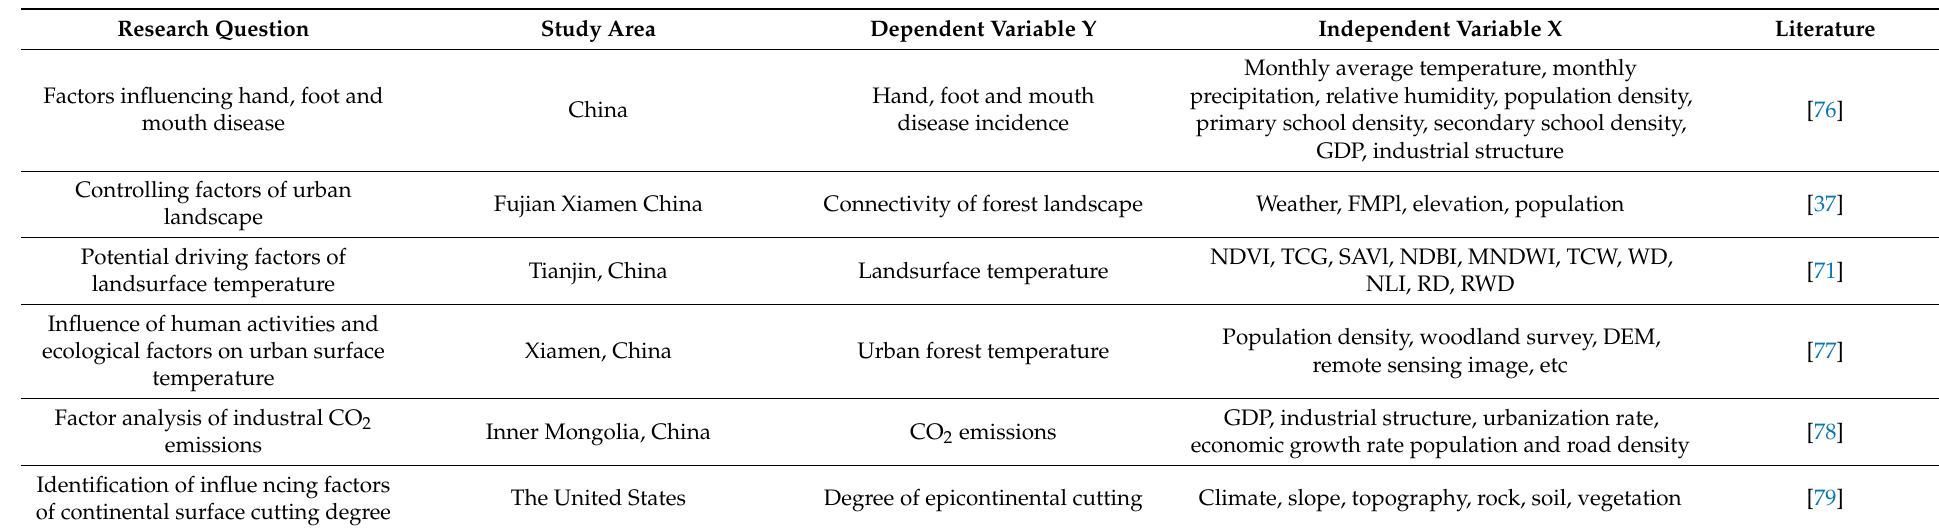
Table A2. More typical applitications of